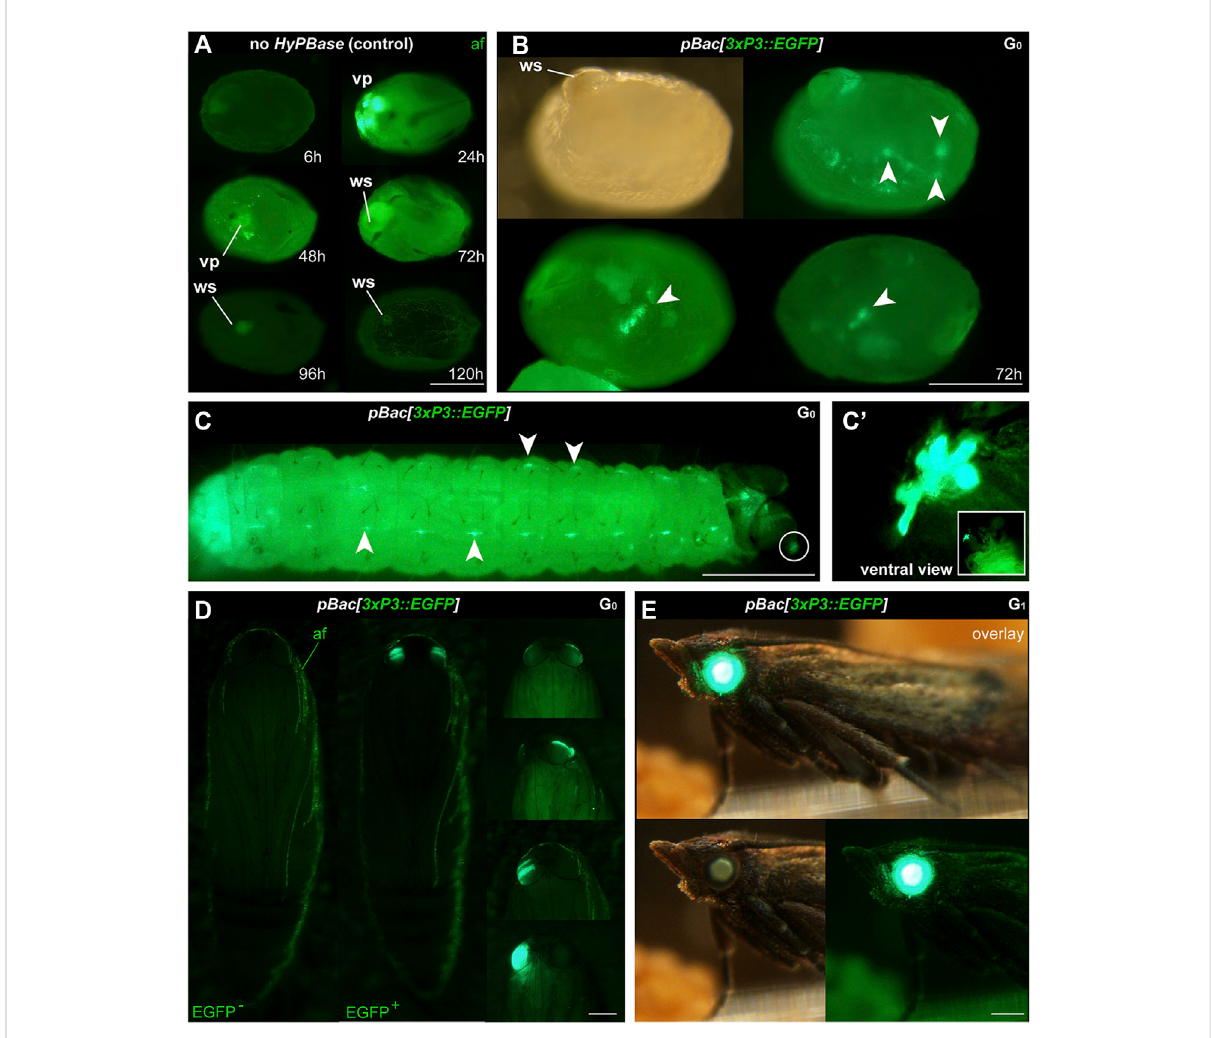
FIGURE 2 Phenotype of transgenic Plodia expressing EGFP in eyes and putative glia. (A) Control injections of pBac[3xP3::EGFP] show variable levels of green auto fl uorescence (af), most markedly at the injection wound site (ws). Episomal expression of EGFP in vitellophages (vp) is intense 24 h post- injection, reduced to background level after 48 h. (B) Donor pBac[3xP3::EGFP] + hyPBase mRNA injections resulted in 3xP3::EGFP expression, emerging as nervous system markings around 72 h post-injection (arrowheads). 23.7% of injected G 0 eggs (262/1,104) showed a similar fl uorescenceduringscreening. (C) 3xP3::EGFP expressionina fi rstinstarlarva,ingangliaoftheCentralNervousSystem(consistentwithanexpected glial reporter activity of 3xP3 ), and in ocellar stemmata (circled, magni fi ed in C ′ ). (D) G 0 mosaics of 3xP3::EGFP expression in pupal eyes. An EGFP- negative pupa is shown on the left for reference. (E) 3xP3::EGFP expression in a G 1 Plodia adult with non-mosaic expression of EGFP in the eye (bottomright).EGFPisalsovisibleinthebright fi eld(bottomright),withagreentintofthecompoundeyesinthe Pi_wFog recessivewhite-eyedstrain. Scale bars: A-C ’ = 200 μ m; D-E = 500